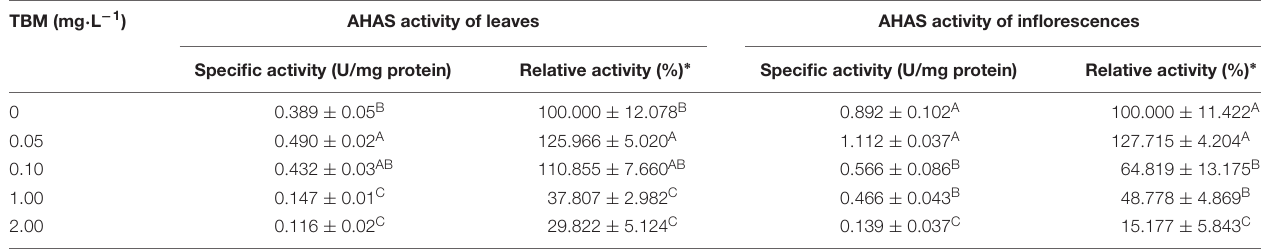
TABLE 5 | Changes of AHAS activity of ZS9 treated with different concentrations of tribenuron-methly (TBM) # .